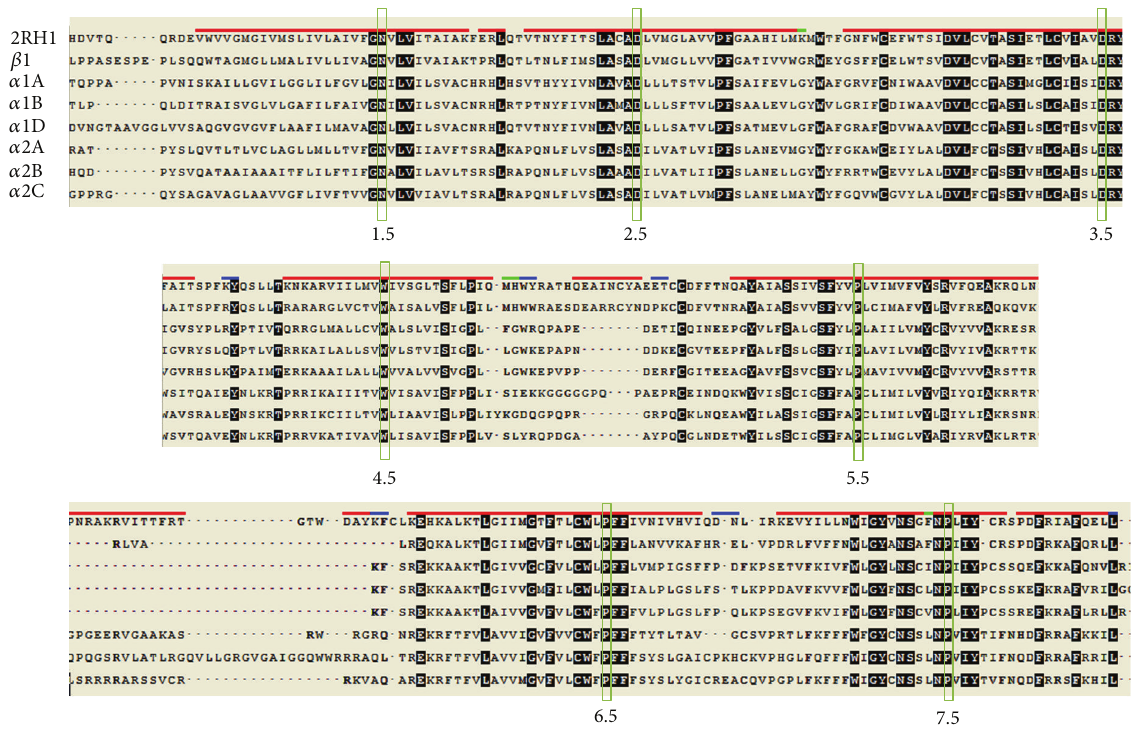
Figure 2: Alignment of the 8 AR subtypes.